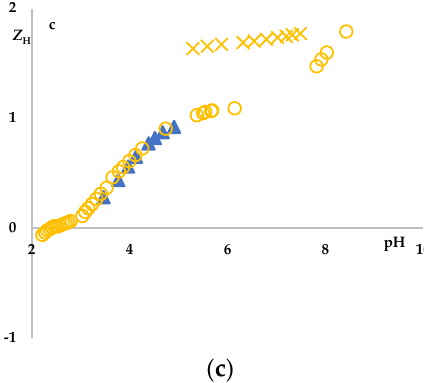
Figure A1. Z H as a function of -log [H + ] for quercetin ( a ), luteolin ( b ) and L -ascorbic acid ( c ), at 37 °C and in 0.16 M NaCl. Orange circles and orange crosses refer to C L 0.5 × 10 −3 M, while blue triangles refer to C L 5 × 10 −3 M.